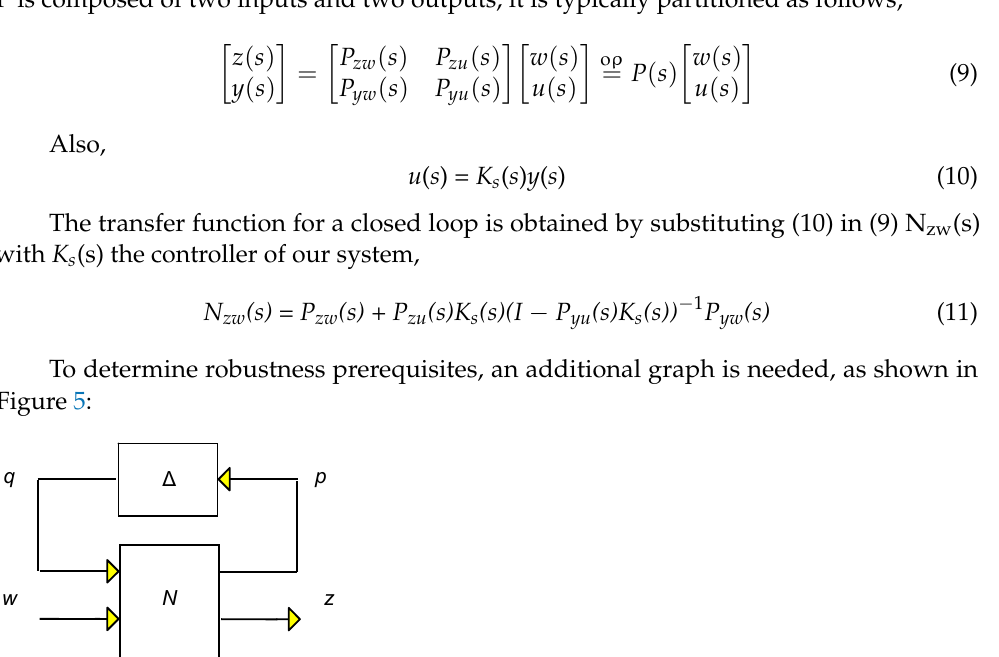
Figure 4. Two-port graph.